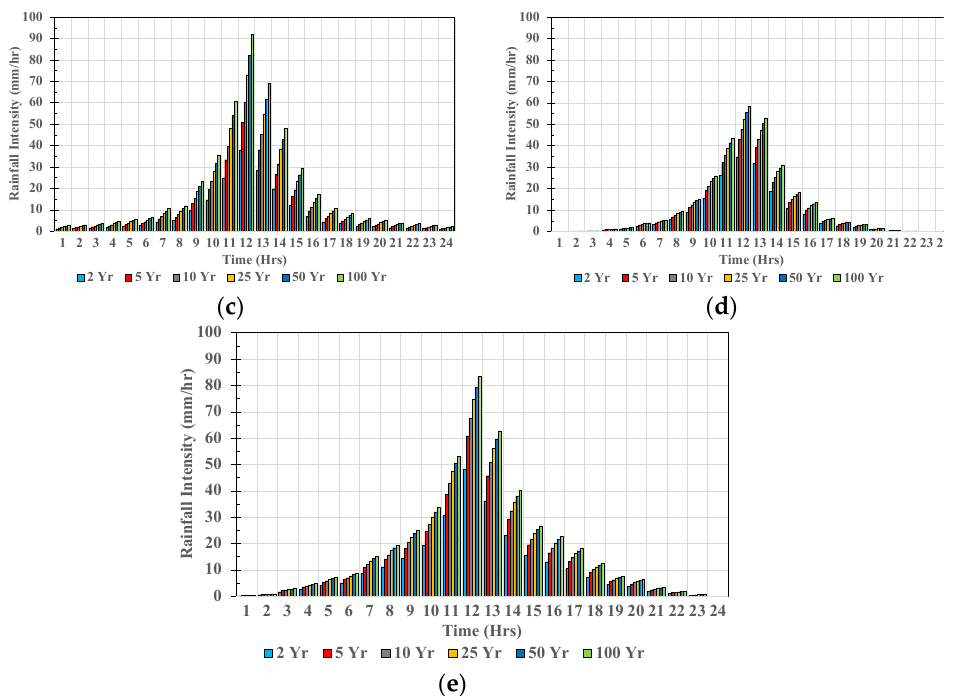
Figure 6. ( a – e ) The hourly rainfall distribution for different return periods in the Yilan River basin at YR_R1-YR_R5.